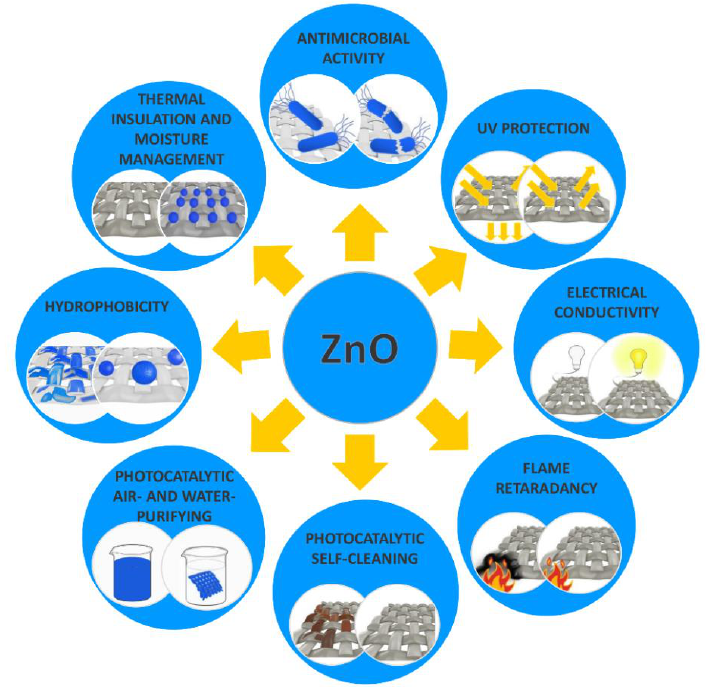
Figure 1. Schematic presentation of the functional properties of ZnO on textile fibers.